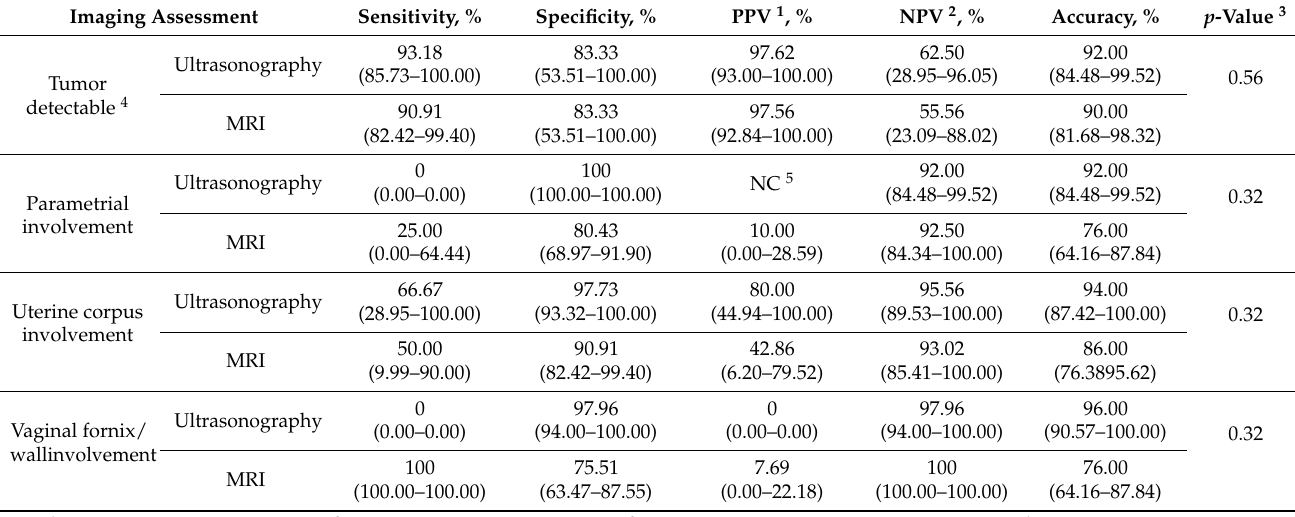
Table 5. Accuracy of ultrasonography and MRI for tumor detection and localizations of the disease ( n = 50). Imaging